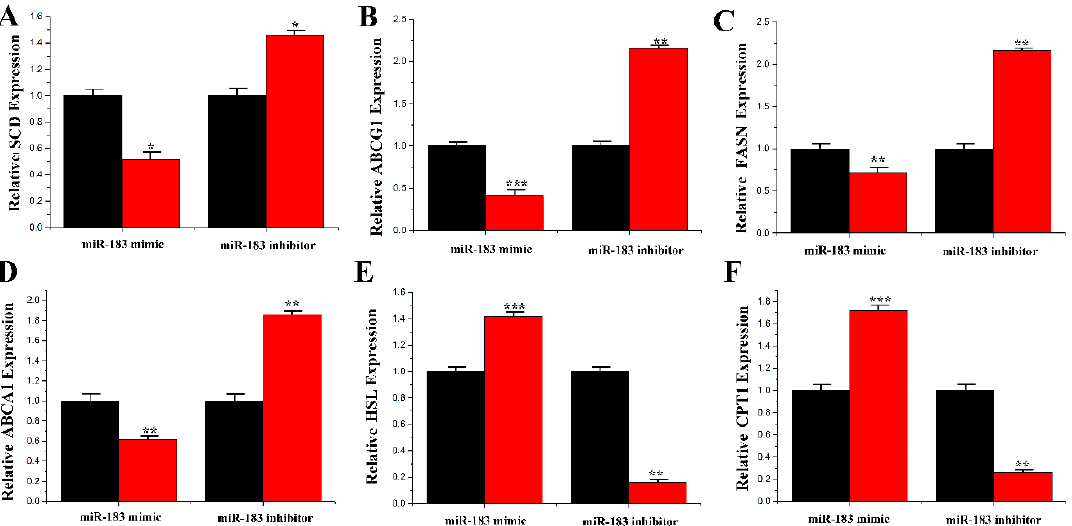
Figure 7. Functional evaluation of miR-183. ( A ) TAG levels in cells transfect with miR-183 mimic or inhibitor; TAG levels in transfected cells were compared with that of miR-183 controls ( n = 6). Red bars represent the negative control; black bars represent miR-183 mimic or inhibitor; ( B ) Cholesterol levels in transfected cells were compared with that of control ( n = 6). Red bars represent the negative control; black bars represent miR-183 mimic or inhibitor; ( C ) The expression of β -casein was quantified by RT-qPCR ( n = 6); ( D ) The effect of miR-183 mimic or inhibitor on β -casein protein expression was evaluated by Western blot in CMECs. Total protein was harvested 48h post-treatment, respectively. All experiments were duplicated and repeated three times. Values are presented as means ± standard deviation, * p < 0.05; ** p < 0.01; *** p < 0.001.